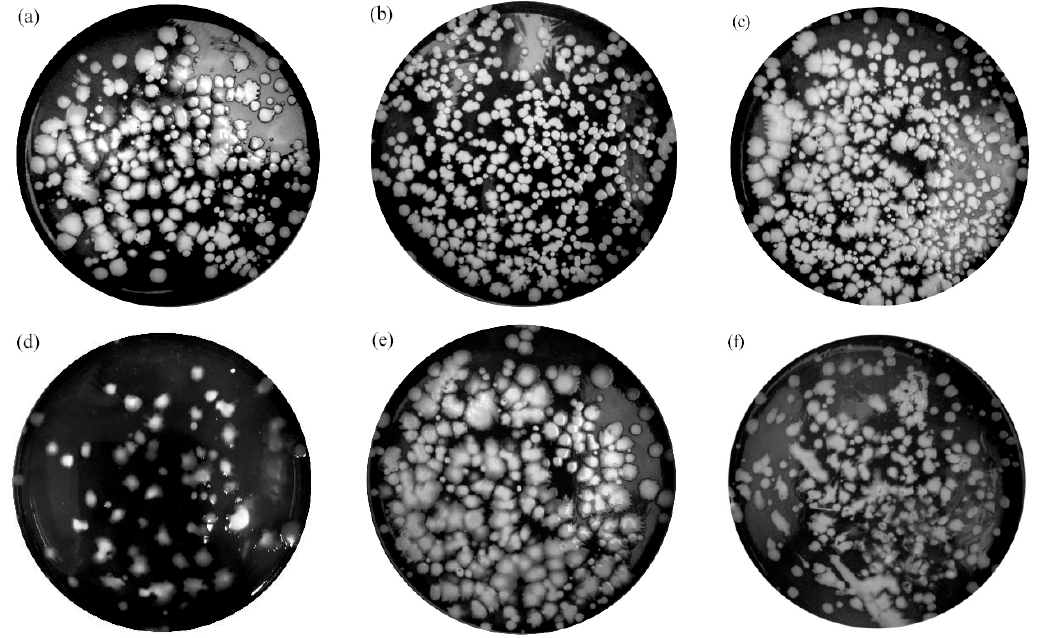
Figure 9. Images of bacterial colonies ( a ) rinsed coating 5011; ( b ) rinsed coating 5012; ( c ) rinsed solvent-based silicone coating; ( d ) washed coating 5011; ( e ) washed coating 5012; ( f ) washed solvent-based silicone coating.